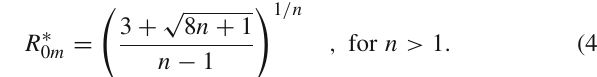
= m ∗ ( R ∗ ) diagram, as well as Ω 0 0 0